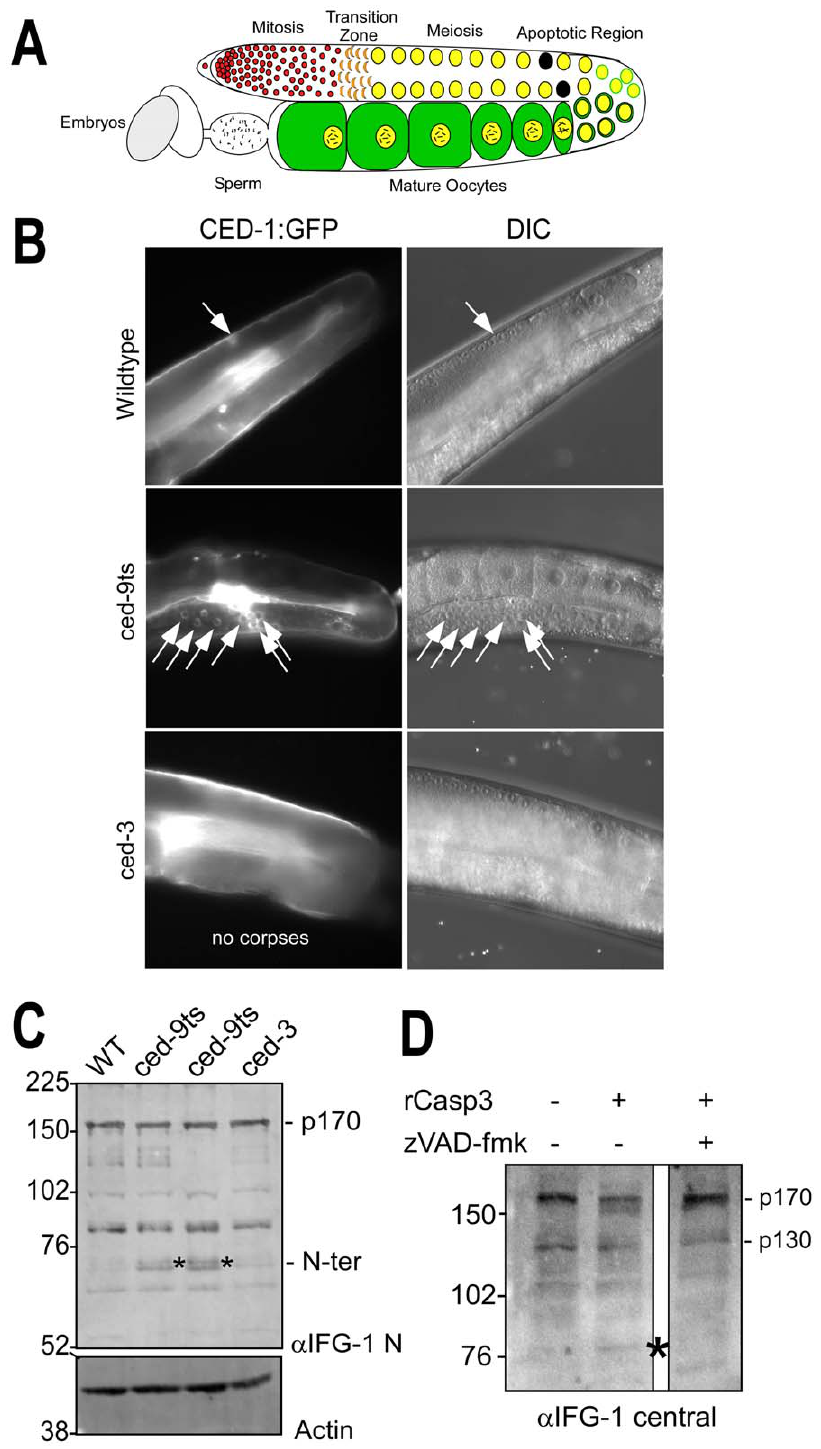
Figure 1. IFG-1 is cleaved during C.elegans apoptosis invivo and by human caspase-3. (A) Diagram depicting one lobe of the adult gonad. Germ cells begin as a stem cell population of mitotically dividing cells in a common cytoplasm that transitions into a meiotic program. As oocytes mature they become fully cellularized and accumulate cytoplasmic components and condensed bivalent chromosomes prior to fertilization. The region of naturally occurring apoptotic cell death is indicated. (B) Fluorescence images depicting germ cell apoptotic events induced by loss of ced-9 function. One lobe of the gonad from adult wild type, temperature-sensitive ced-9ts (n1653), and ced-3 (n2452) strains expressing the apoptotic marker CED-1::GFP are shown. GFP-positive apoptotic corpses are designated by white arrows. Overlapping DIC images to the right demonstrate normal gonad and oocyte morphologies. In the wild type and ced-3 panels, the path of the intestine has obscured fully grown oocytes in the proximal arm, but younger oocyte nuclei are visible in the distal arm prior to the bend, in the region where germ cell apoptosis occurs. (C) Western blot of IFG-1 p170 cleavage in vivo in ced-9(ts) adult worms. Worms treated 48h at 25 u C were homogenized and the extract analyzed by 8% SDS-